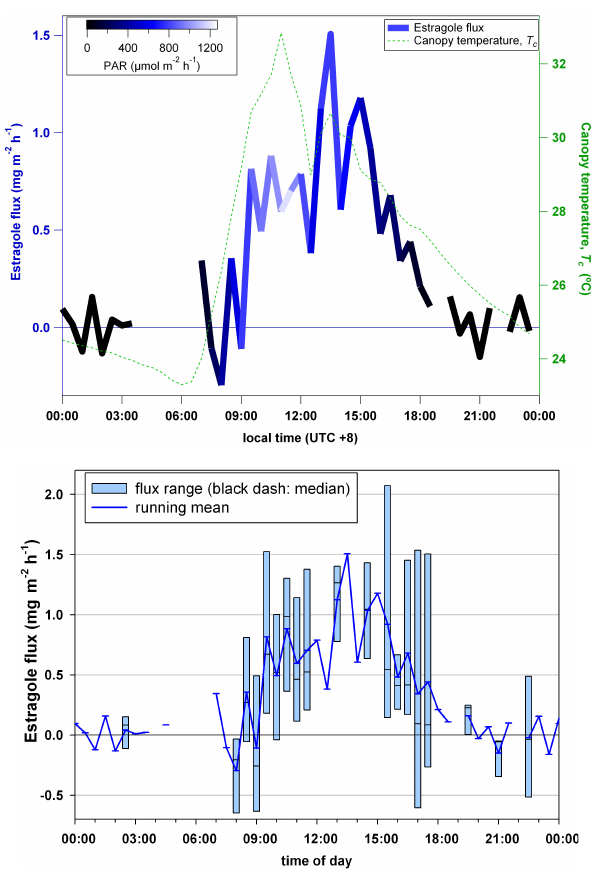
Fig. 6. Average diurnal cycles of the estragole flux: (a) in compar- ison with canopy temperature (right axis), and shaded by PAR; (b) Box-and-Whisker plots showing day-to-day